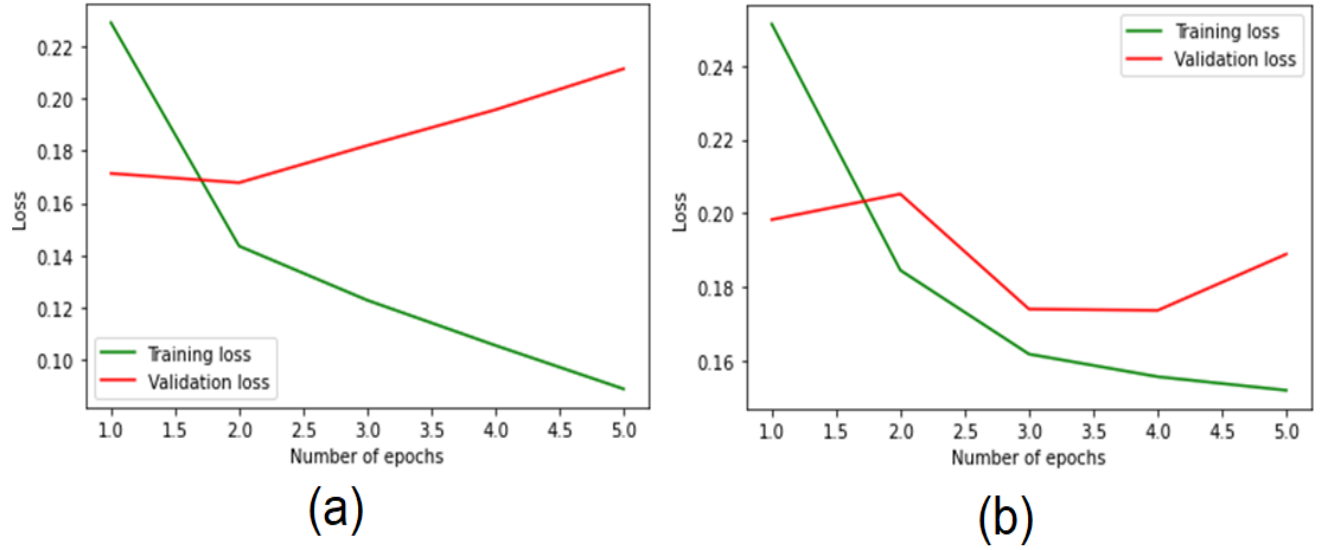
Figure 8. Accuracy loss of the ( a ) CNN-BiLSTM and ( b ) BiLSTM models using the binary dataset.